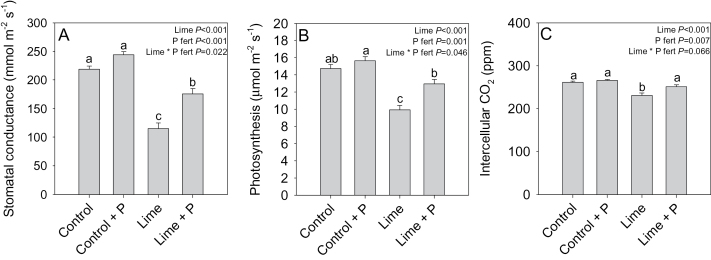
Stomatal conductance (A), net photosynthesis (B), and intercellular CO2 concentration (C) of control, control+P fertilizer-, lime-, or lime+P fertilizer-treated Pisum sativum. Data are means ±SE of 8–10 replicates with two-way ANOVA results (P-values reported) shown. Different letters above each bar indicate significant differences (P<0.05) as determined by Tukey pair-wise analysis.